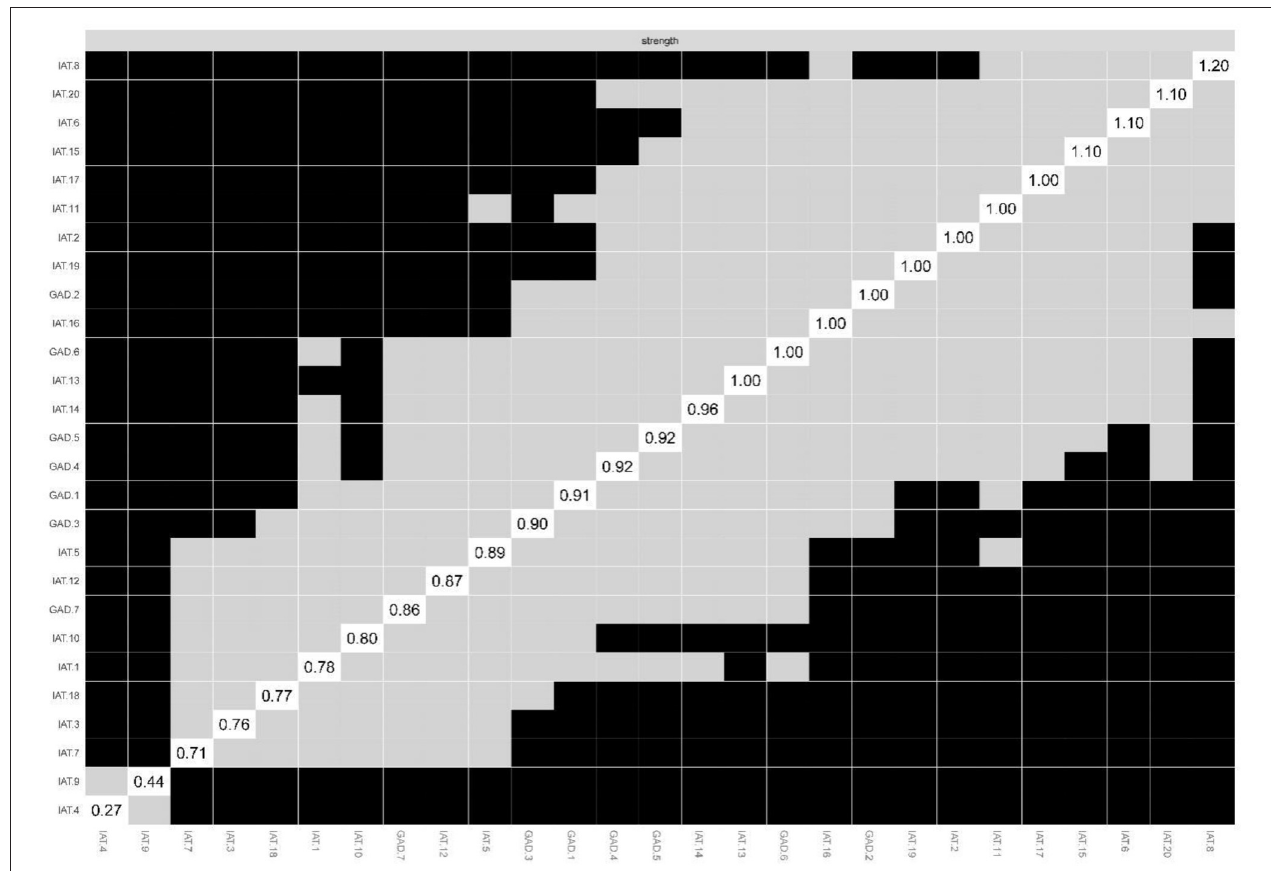
FIGURE 4 | Non-parametric bootstrapped difference test for strength. Gray boxes indicate no difference between nodes, whereas black boxes indicate significant difference ( α = 0.05). Values reported in the diagonal represent the strength values of each